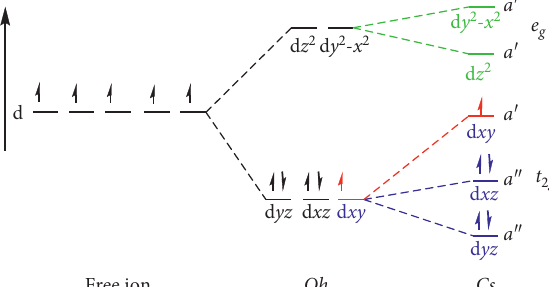
Figure 3: Suspected weak Jahn–Teller distortions on complex 4 Note . The diagram is not to scale. The diagram demonstrates that the e orbitals transform under the a ′ symmetry label while the t orbitals transform under the a ′ , a ″ , and a ″ ; this observation suggests the weak 2 g Jahn–Teller distortion. This explains why the observed effective magnetic moment was a bit lower than the expected magnetic moment which is because of the unpaired electron not having orbital contribution from interacting with the other orbitals, thus having no effect on the magnetic